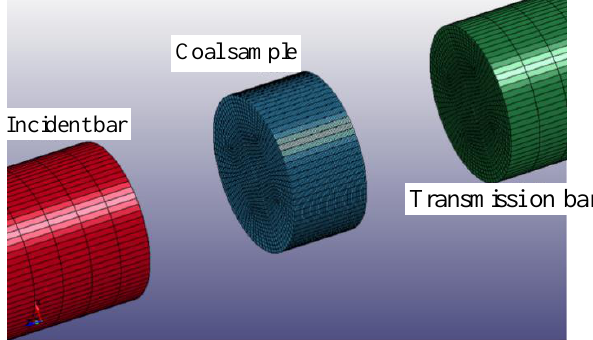
Figure 13. Establishment of the finite element model.